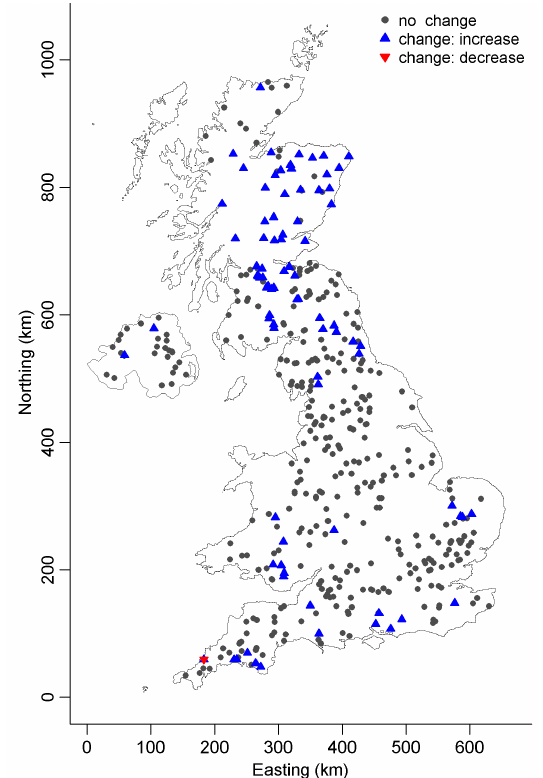
Fig. 6. Results for a Mann–Kendall test of no change in the annual series of the 99th quantile for daily rainfall. Significance tested at a α MK = 0 . 05